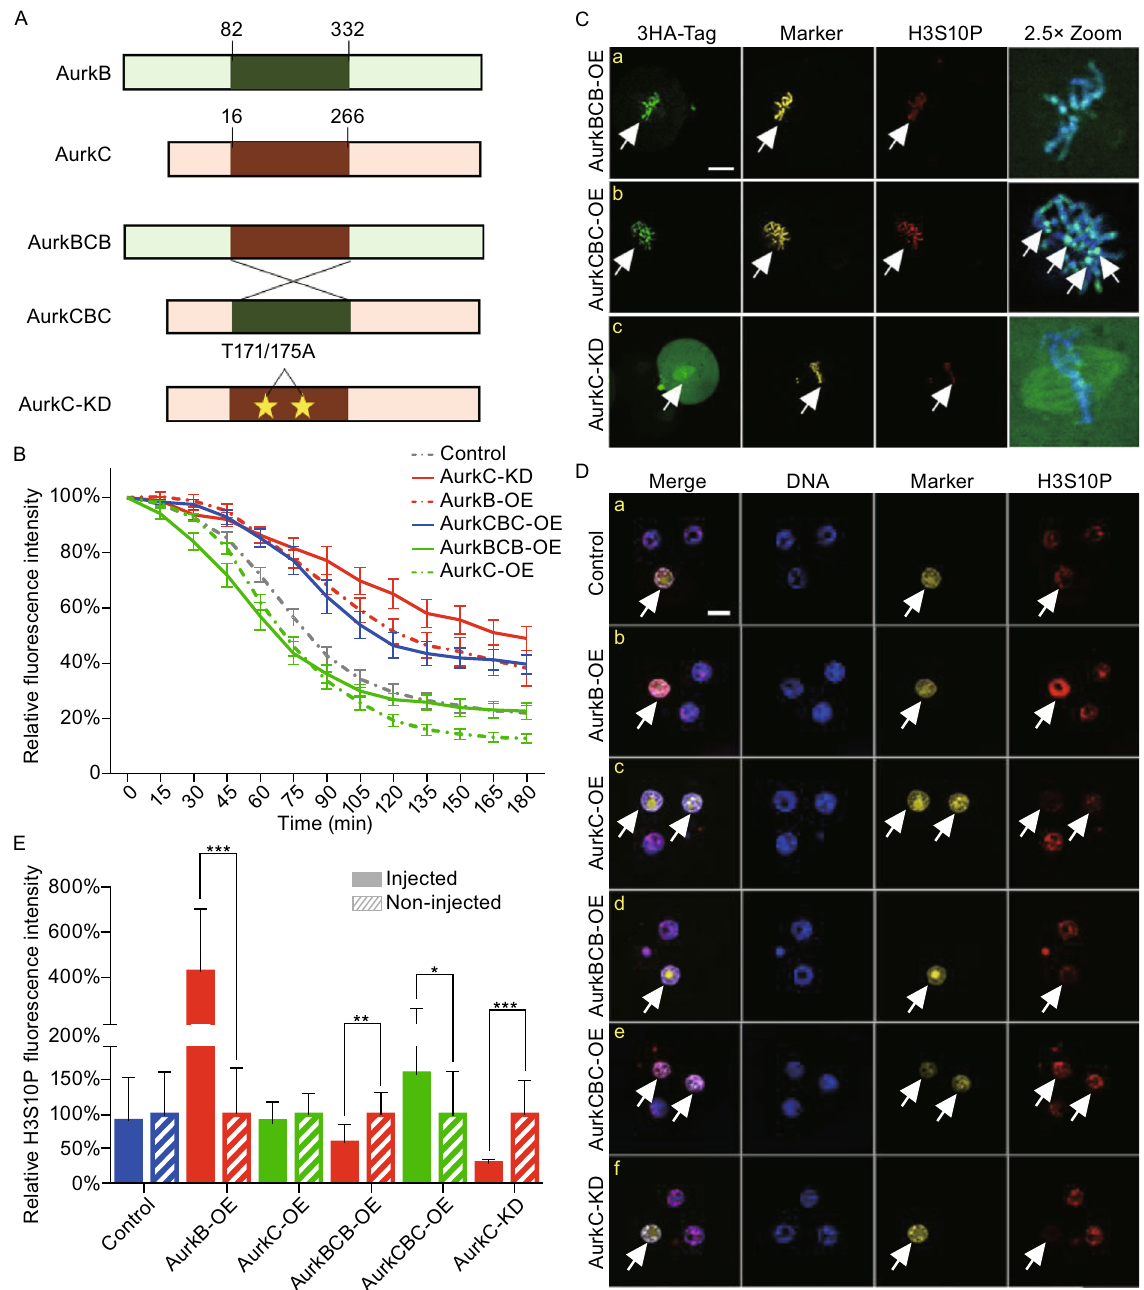
Figure 2. The kinase domain of AurkB and AurkC determined their biological activity. (A) Schematic view of the domain structure of AurkB, C, CBC, BCB, and kinase de fi cient AurkC-KD. (B) The Securin-mCherry fl uorescence (Y-axis) degradation curve in AurkBCB-OE ( n = 21), AurkCBC-OE ( n = 22), and AurkC-KD ( n = 26) groups, from NEBD to sister chromatids separation. Y-axis, fl uorescence intensity; X-axis, time (min). The continuous line and whiskers indicate means and SEM. (C) 3HA-AurkBCB, CBC, and AurkC-KD localization during 2 – 4 cell stage division. DNA (blue), 3HA-tag (green), H2B-GFP (yellow), H3S10P (red). Scale bar, 20 μ m. (D) H3S10P immunostaining of 4-cell stage embryos in the control ( n = 26), AurkB-OE ( n = 28), AurkC-OE ( n = 24), AurkBCB- OE ( n = 30), AurkCBC-OE ( n = 22), and AurkC-KD ( n = 24) groups. DNA (blue), H2B-GFP (marker, yellow), H3S10P (red). Scale bars, 20 μ m. (E) Relative fl uorescence intensity of H3S10P in injected and no injected cells. Control ( n = 26), AurkB-OE ( n = 28), AurkC-OE ( n = 24), AurkBCB-OE ( n = 30), AurkCBC-OE ( n = 22), and AurkC-KD ( n = 24) groups. The bar and whiskers indicate means and SD, * P < 0.05, ** P < 0.01, *** P <